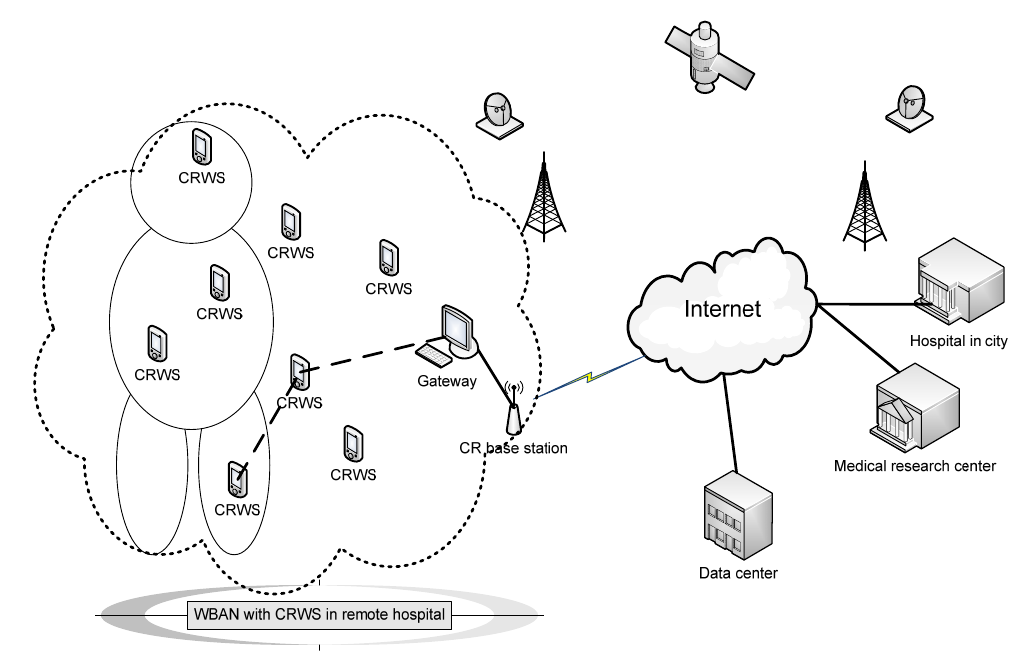
Figure 3. Wireless body area network with